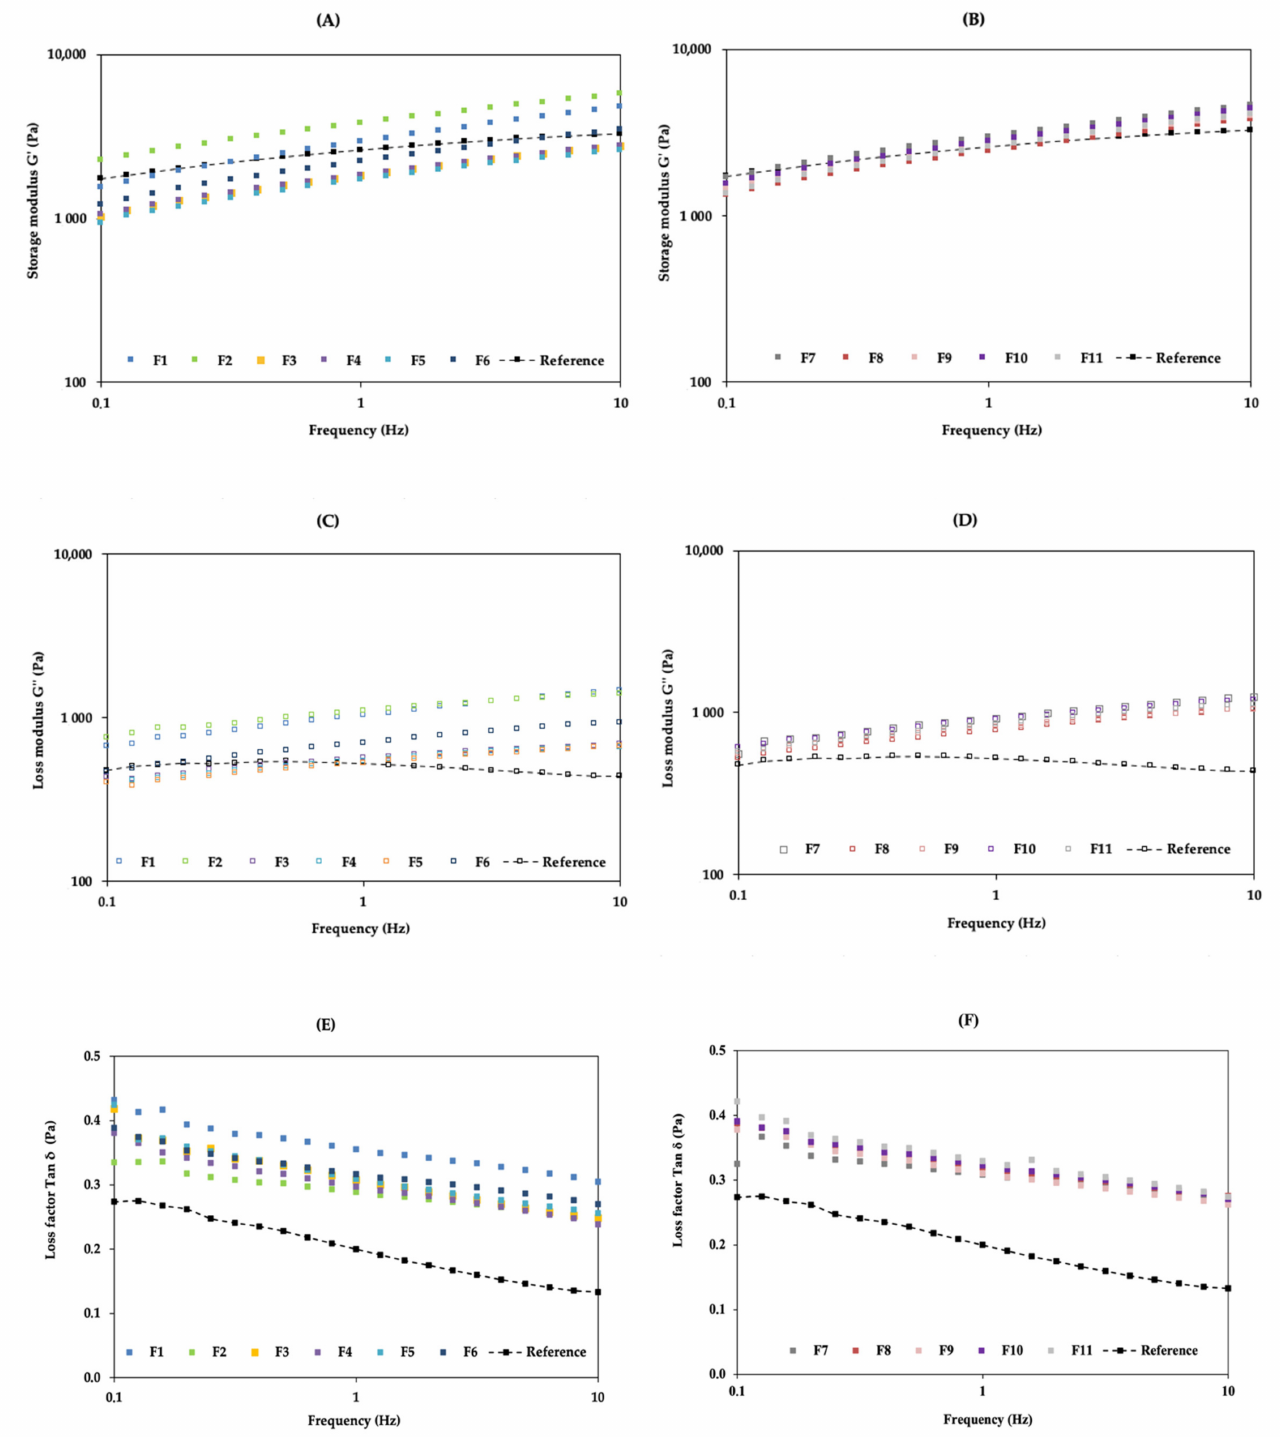
Figure 3. Effect of independent variables on formulations’ storage modulus (G (cid:48) ): ( A ) F1–F6 and RF; ( B ) F7–F11 and RF; effect of independent variables on formulations’ loss modulus (G”): ( C ) F1–F6 and RF; ( D ) F7–F11 and RF; effect of independent variables on formulations’ loss factor (Tan δ ): ( E ) F1–F6 and RF; ( F ) F7–F11 and RF. The results shown are means, n =